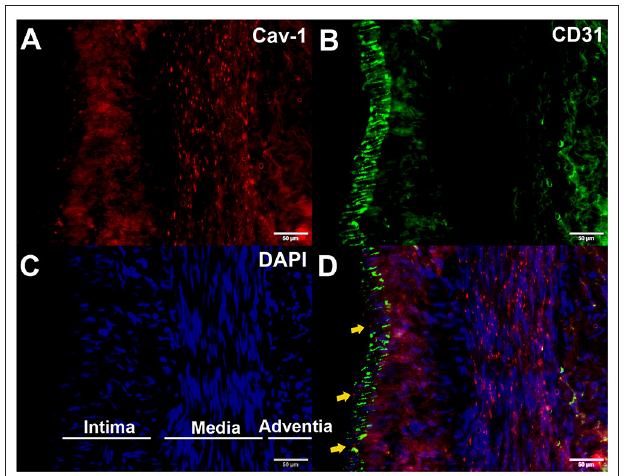
FIGURE 4 | Enhanced expression of Cav-1 in the superficial temporal artery (STA) of patients with MMD. The STA samples from patients with MMD were stained with Cav-1 (red, A ), CD31 (green, B ), and 4’,6-diamidino-2-phenylindole (DAPI) (blue, C ). Cav-1 was mainly located in the intima and media of the STA (yellow arrows, (D) ). Scale bar = 50 µ